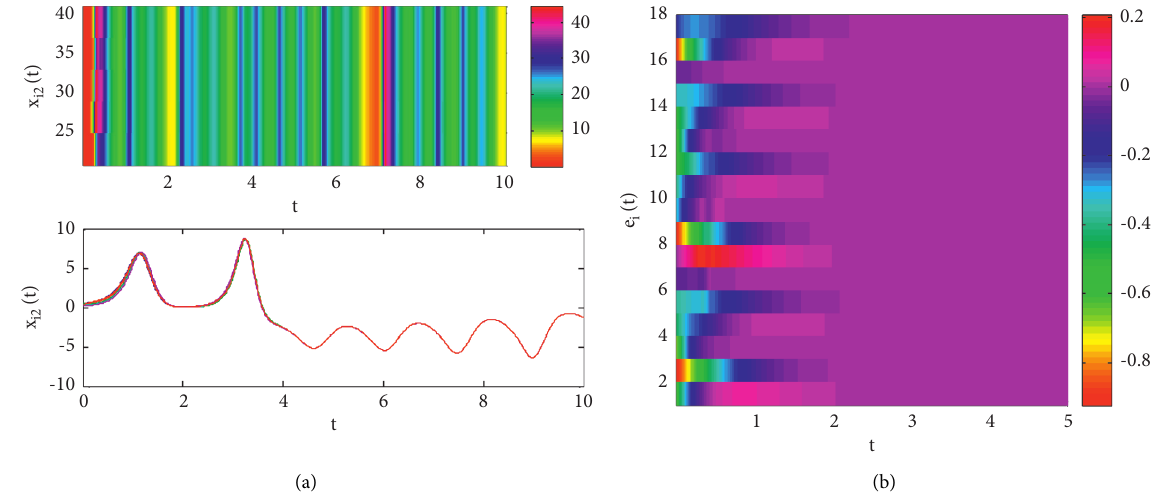
Figure 7: The evolution of state variables and the synchronization error in the second